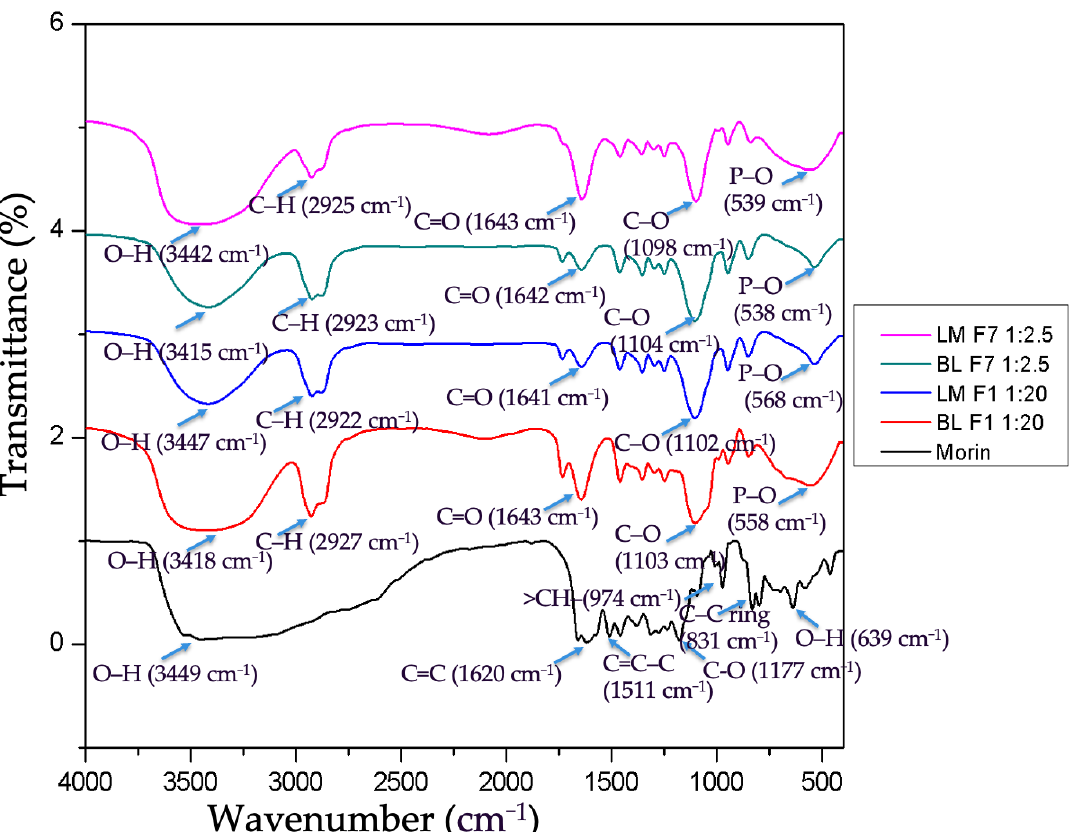
Figure 7. FTIR spectra of morin, liposomal morin formulation 1 (LMF1), 7 (LMF7); blank liposome formulation 1 (BLF1), 7 (BLF7).